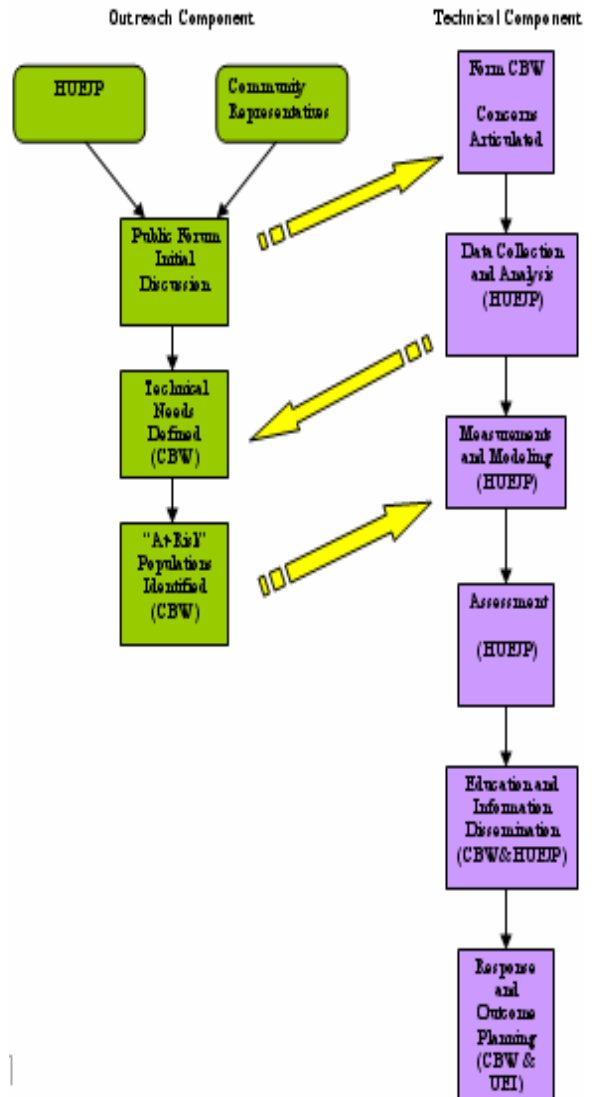
Figure 1: Model of HUEJP Program